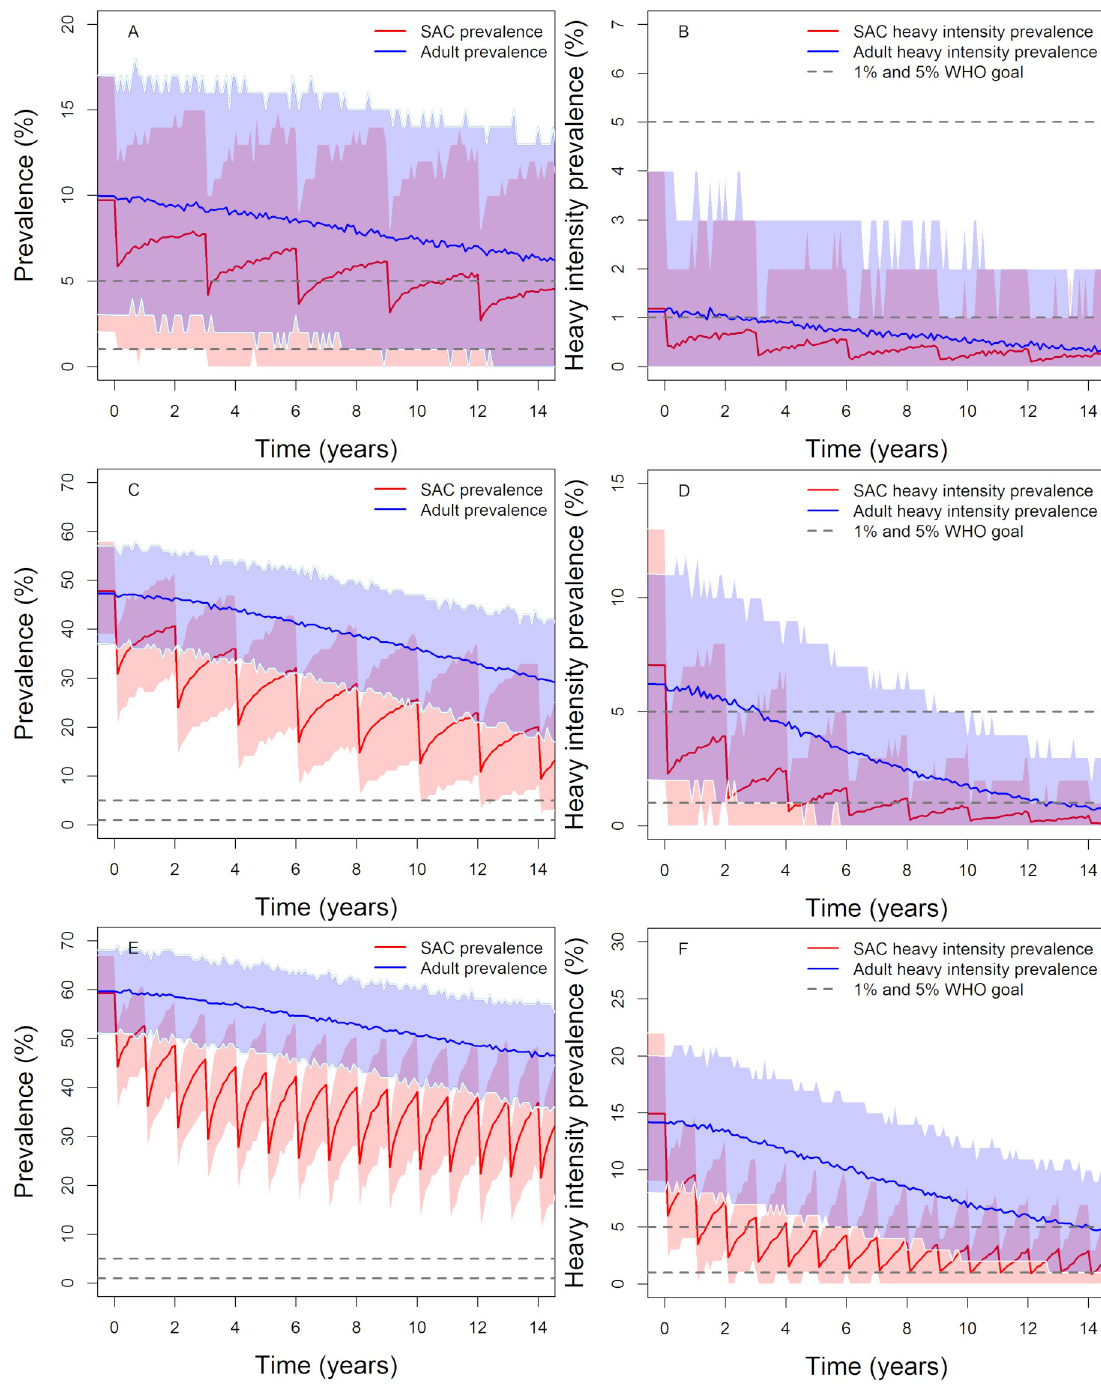
Fig 2. Model projections of MDA treatment of 75% school-aged children (SAC; 5–14 years of age) in low (first row), moderate (second row) and high (thrird row) baseline transmission settings. Graphs A, C and E show the prevalence of infection, Graphs B, D and F show the prevalence of heavy-intensity infections in school-aged children (SAC) and adults. The WHO target of 75% SAC coverage is assumed from the start of treatment programme throughout the 15 years of treatment. Treating annually (low settings) or twice a year (moderate settings) reaches the 5% morbidity and 1% elimination as a public health problem goals by year 15. Shaded areas (both blue and red) represent the 90% credible interval (90% of the simulated results fall within these shaded areas).